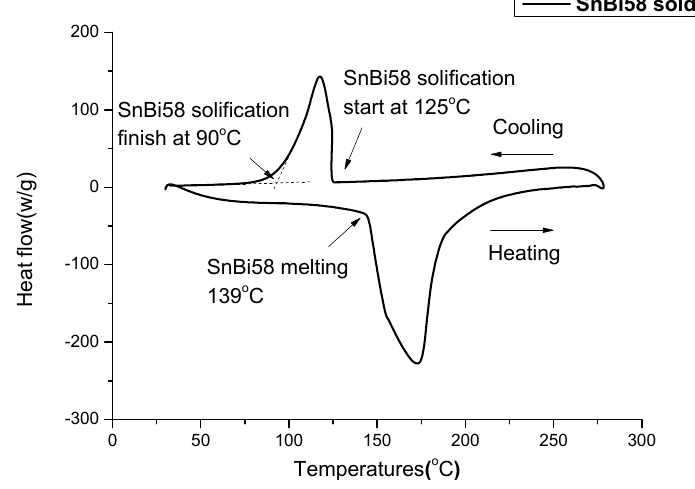
Figure 20. DSC behaviors of SnBi58 solder during heating and cooling process.